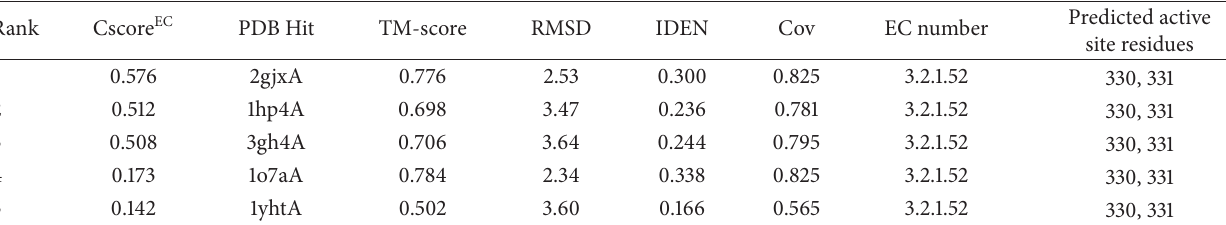
Table 3: Top 5 enzyme homologs in PDB by COFACTOR.